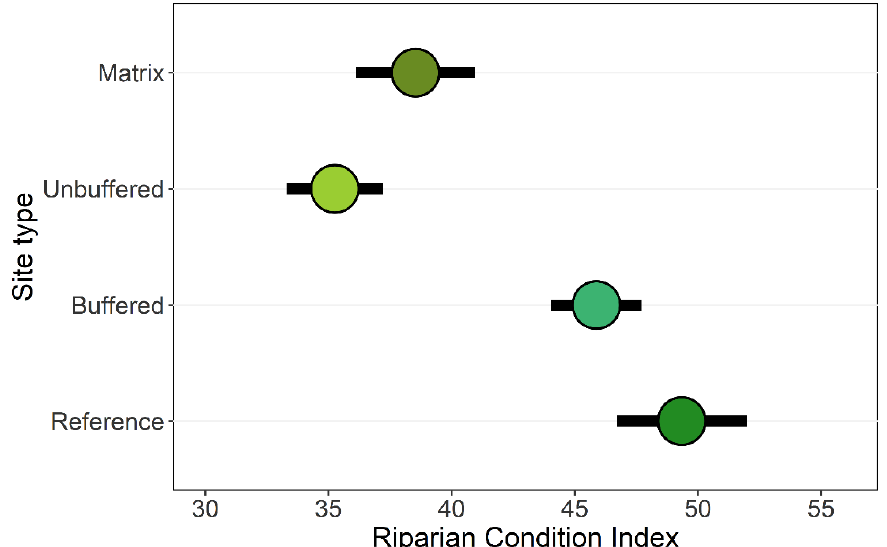
Figure 2. Mean values ( ± 95% CI) of the Riparian Condition Index for site types in the CROSSLINK project (including sites in Norway, Sweden, Belgium, and Romania). “Matrix” refers to sites that were typically located further downstream in our catchment landscape matrices (i.e., the portion of the heterogeneous landscape in which stream-riparian segments are “embedded”).